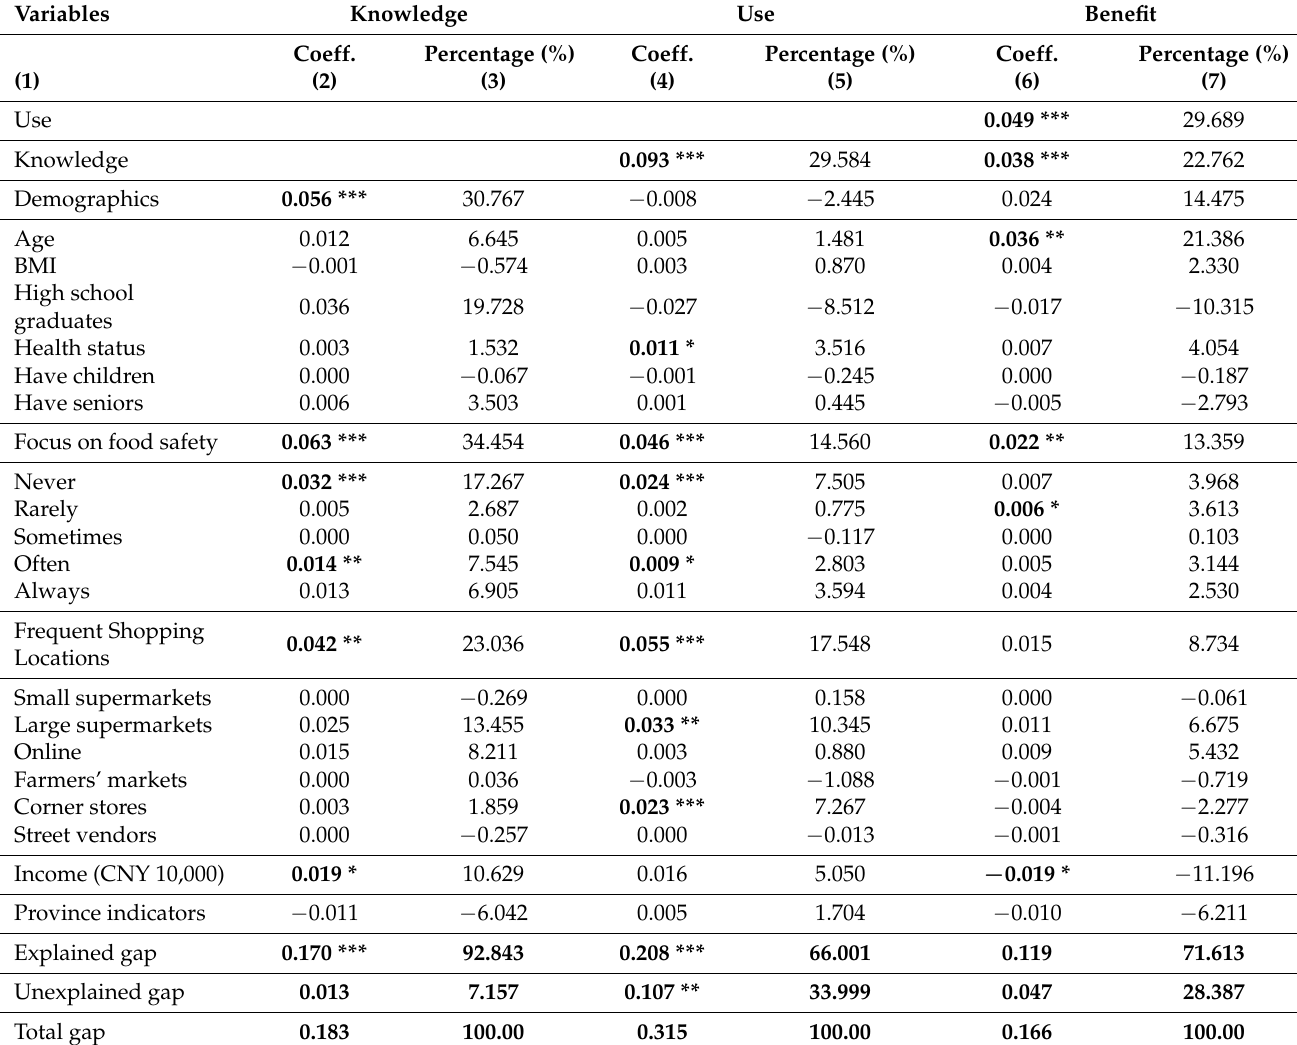
Table 4. Oaxaca–Blinder decomposition results of urban–rural disparities in knowledge, use and benefit